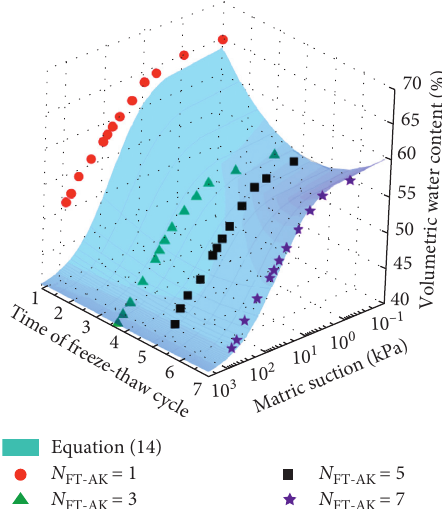
Figure 17: The three-dimensional fitting results under different times of freeze-thaw cycle for AK